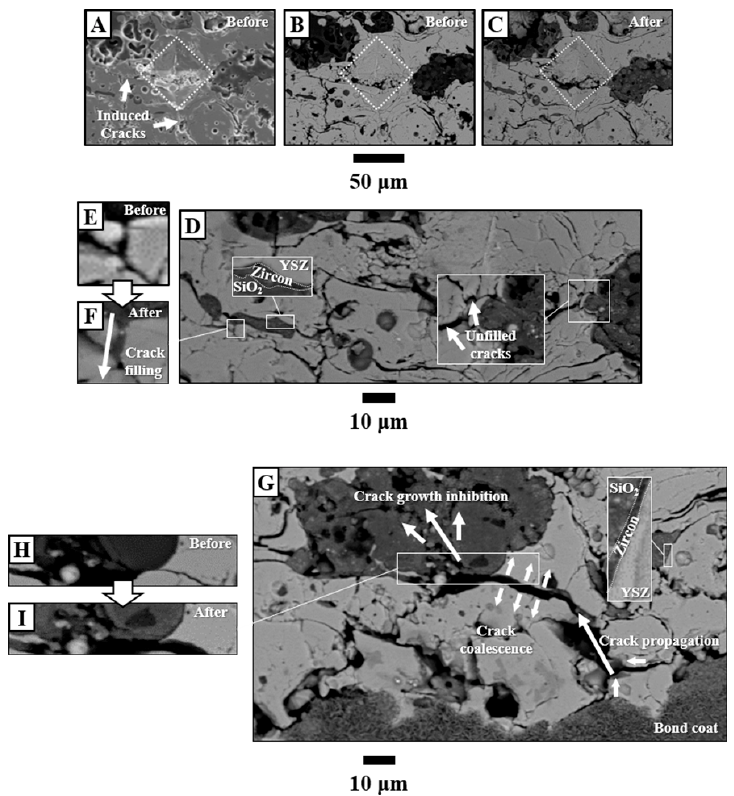
Figure 11. Microstructure around the indentation imprints in sample C before and after heat treatment. Microstructures of the as ‐ coated sample are shown in ( A ), ( D ), and ( G ), and those after heat treatment are shown in ( B ), ( C ), ( E ), ( F ), and ( H ).